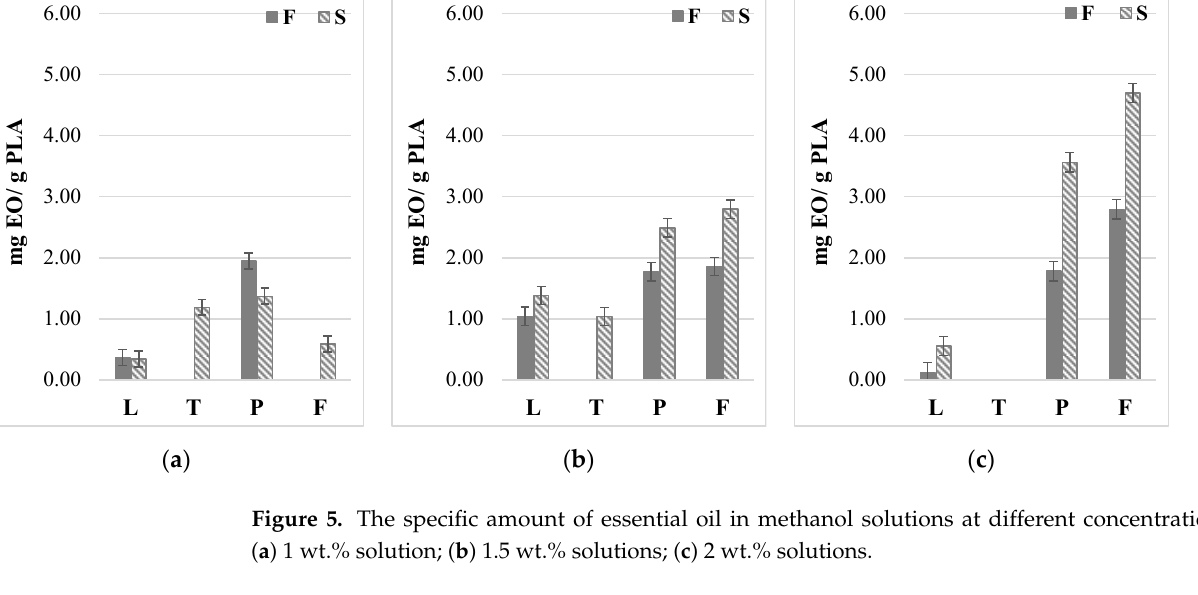
( c ) Figure 6. The specific amount of essential oil in hexane solutions at different concentrations: ( a ) 1 wt.% solution; ( b ) 1.5 wt.% solutions; ( c ) 2 wt.% solutions.